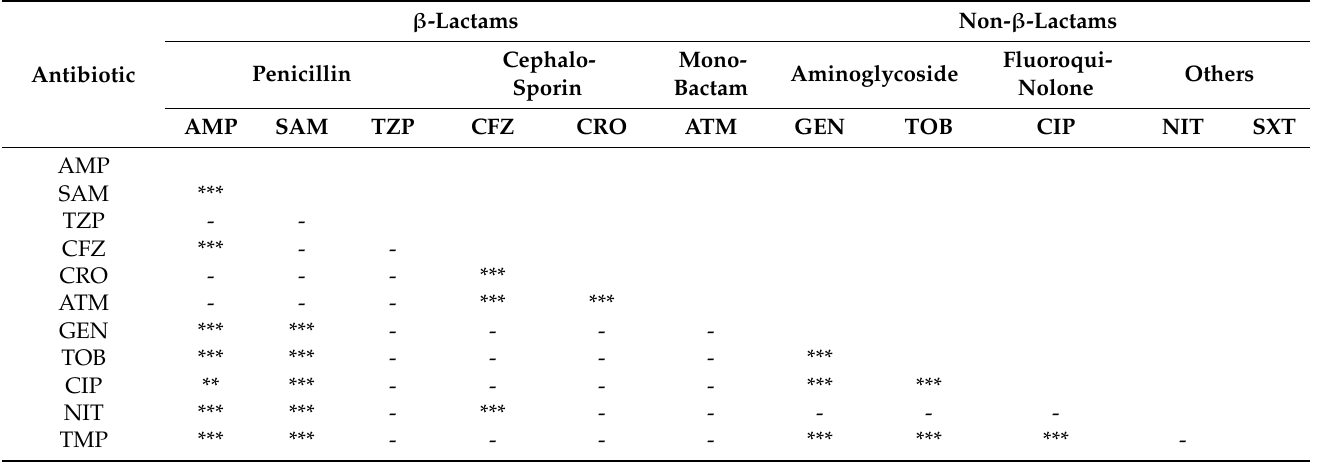
Table 5. Tests for associations between antibiotic resistance phenotypes in E. coli isolates. Symbols represent levels of significance by p -values.